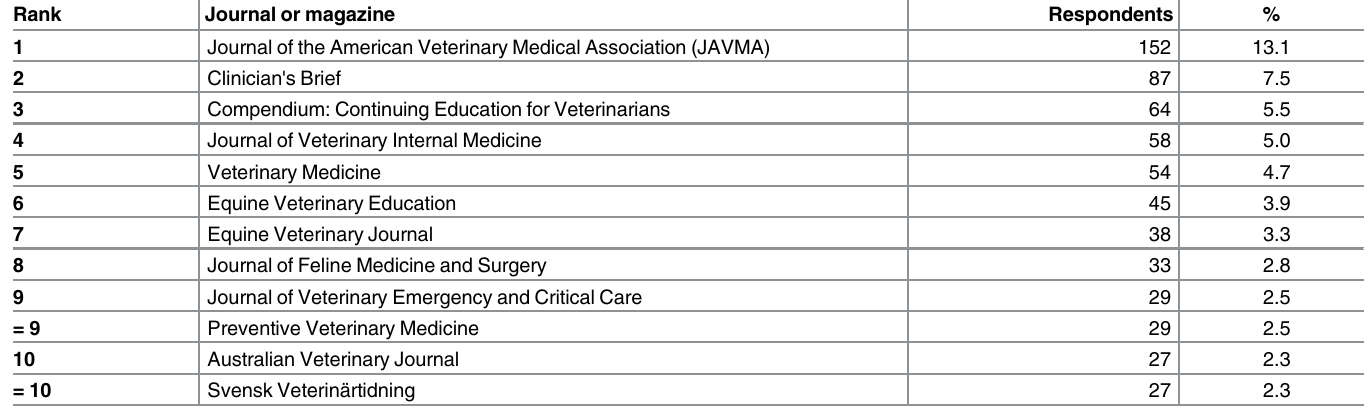
Table 8. Top 10 journals nominated by respondents as most useful (n =